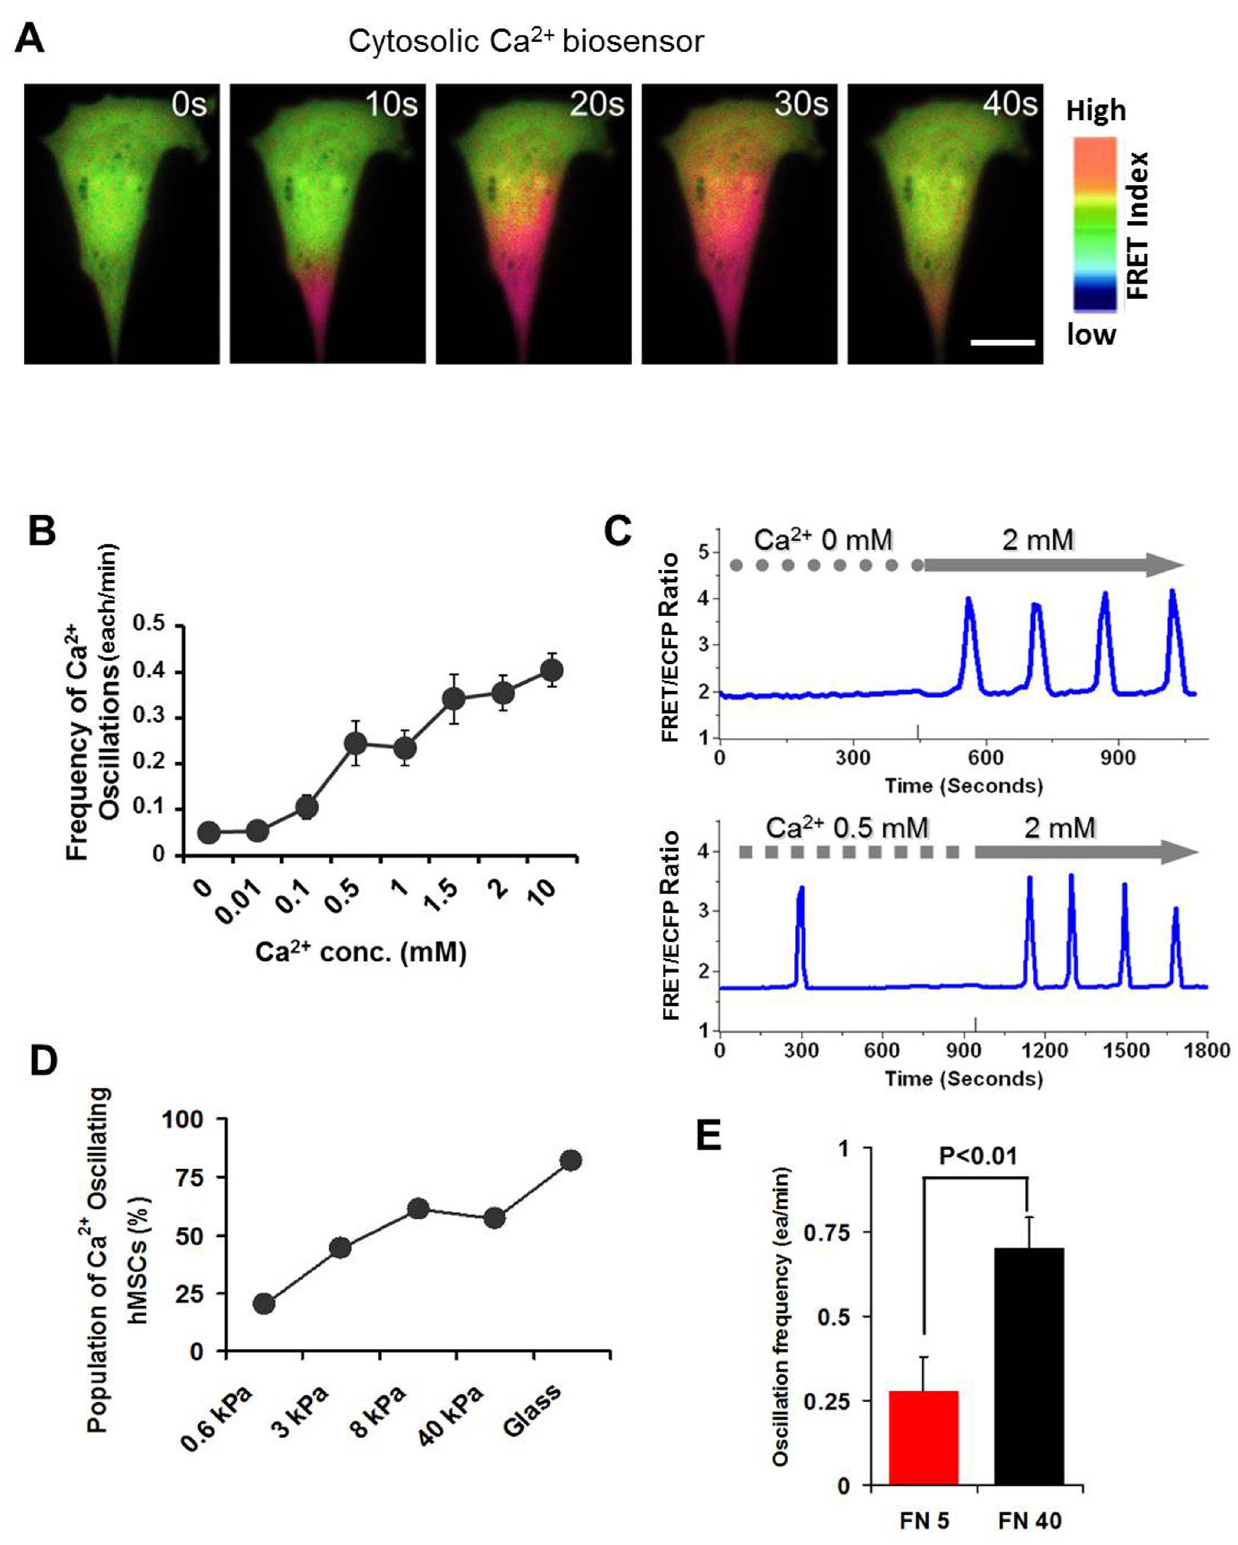
Figure 1. Calcium oscillations depend on the extracellular calcium concentration and mechanical microenvironment. (A) Cytosolic FRET-based calcium sensor shows the intracellular calcium dynamics with high spatiotemporal resolutions in hMSC. Red and blue colors represent the high and low FRET ratios, respectively. Images were captured in 10 second interval. Scale bar, 20 m m. (B) Frequency of calcium oscillations (the number of peaks per minute) is measured in cells subjected to various extracellular calcium concentrations (0 mM to 10 mM, n=14–32). (C) Time courses of calcium signals as imaging medium is replaced with physiological calcium concentration (2 mM). (D) Estimated percentage of hMSCs